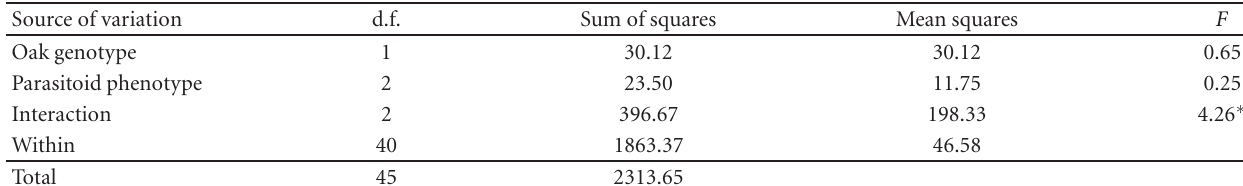
Table 5: Results of two-way ANOVA on the parasitoid thorax lengths variation in dependence on the parasitoid tibia phenotype and genotypes of oaks (presence or absence of the OPA 14–5 DNA fraction; see Figure